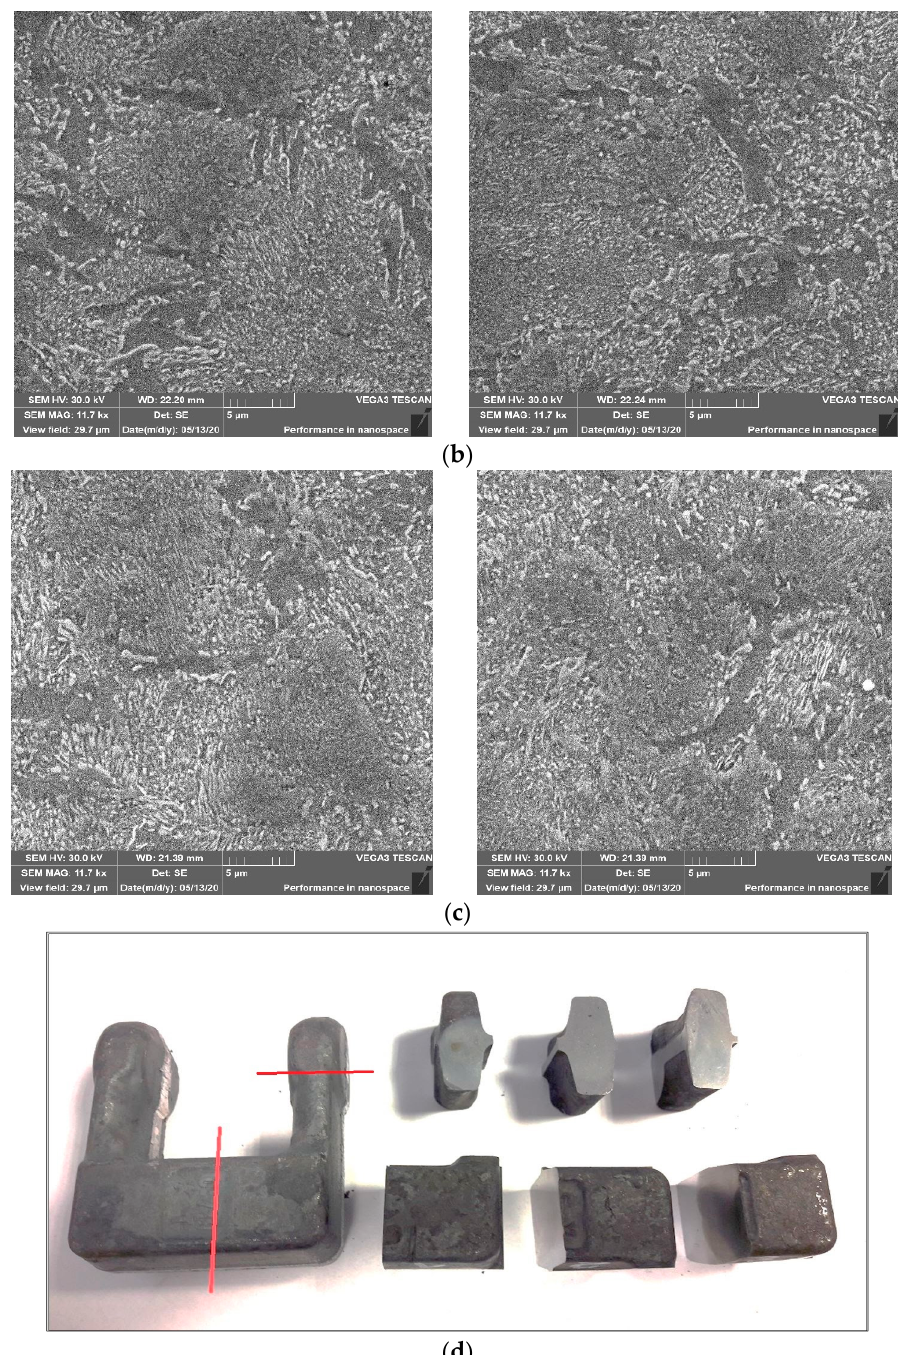
Figure 5. SEM scanning microscopic analysis after three proposed treatment variants (hardening) directly after the forging process: ( a ) technology I, ( b ) technology II, ( c ) technology III, and ( d ) the places of the metallographic specimens was sampled.